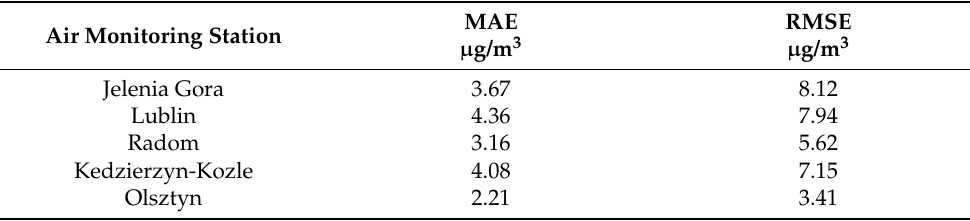
Table 7. Approximation error values of PM 2.5 concentrations obtained using the neural network trained on data from